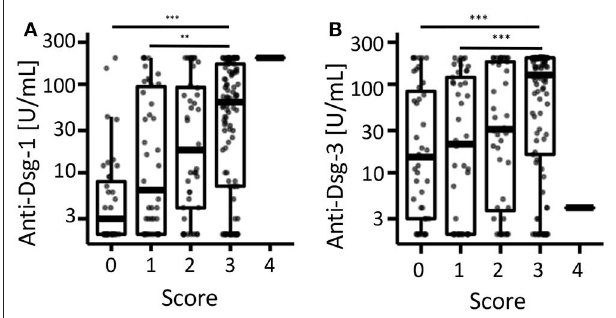
FIGURE 2 | Correlation of anti-desmoglein-antibodies with the retrospective clinical score. The individual serum concentrations of (A) anti-desmoglein-1- and (B) anti-desmoglein-3-antibodies were depicted after stratification according to the retrospective score (0 = clear, 1 = almost clear, 2 = mild,